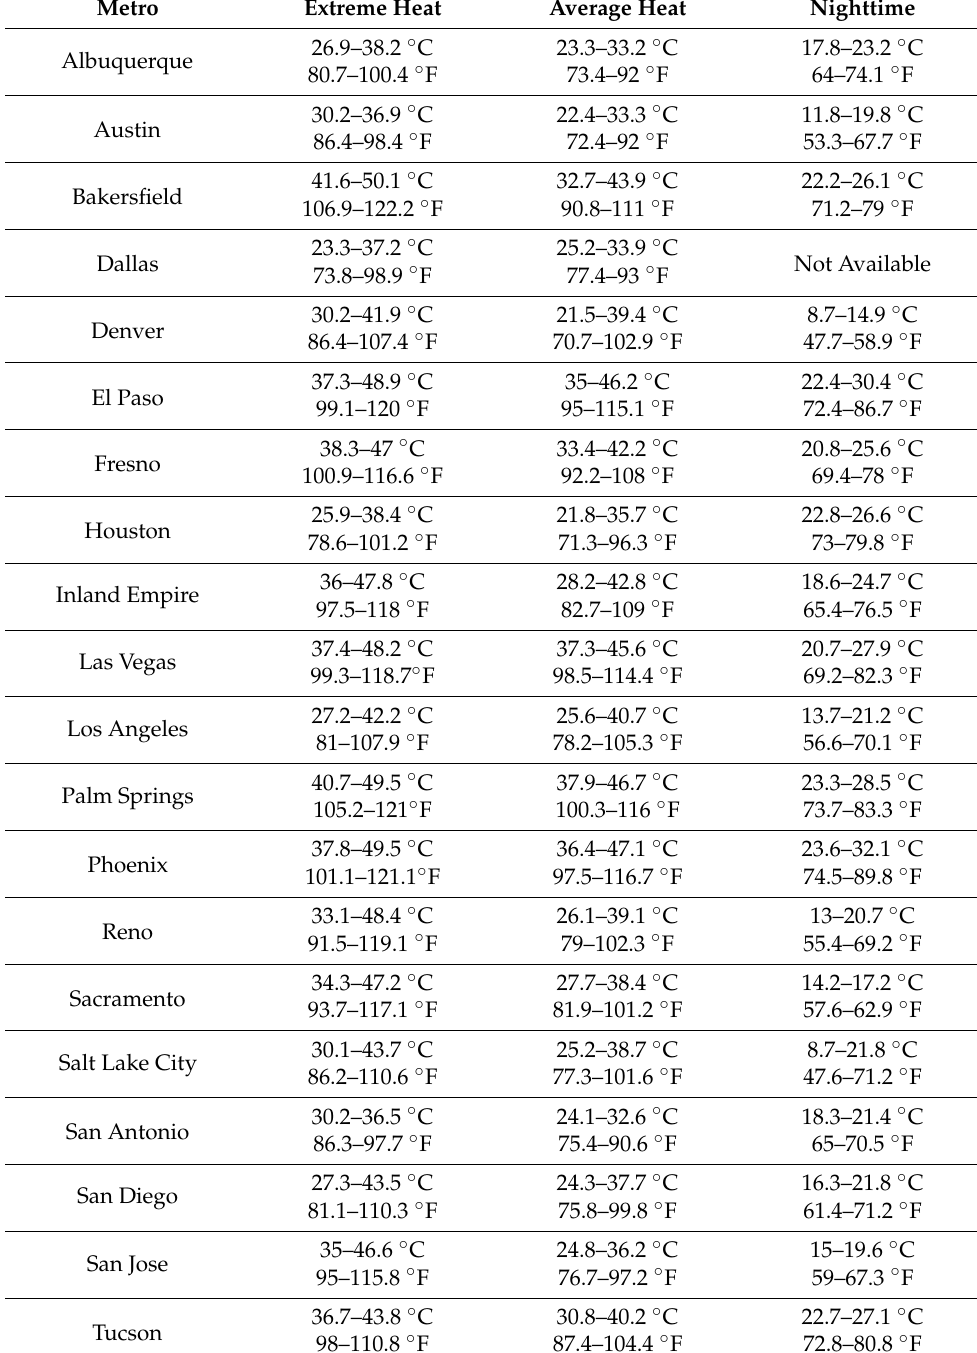
Table A2. Land surface temperature ranges of each metro area for the three temperature scen- arios